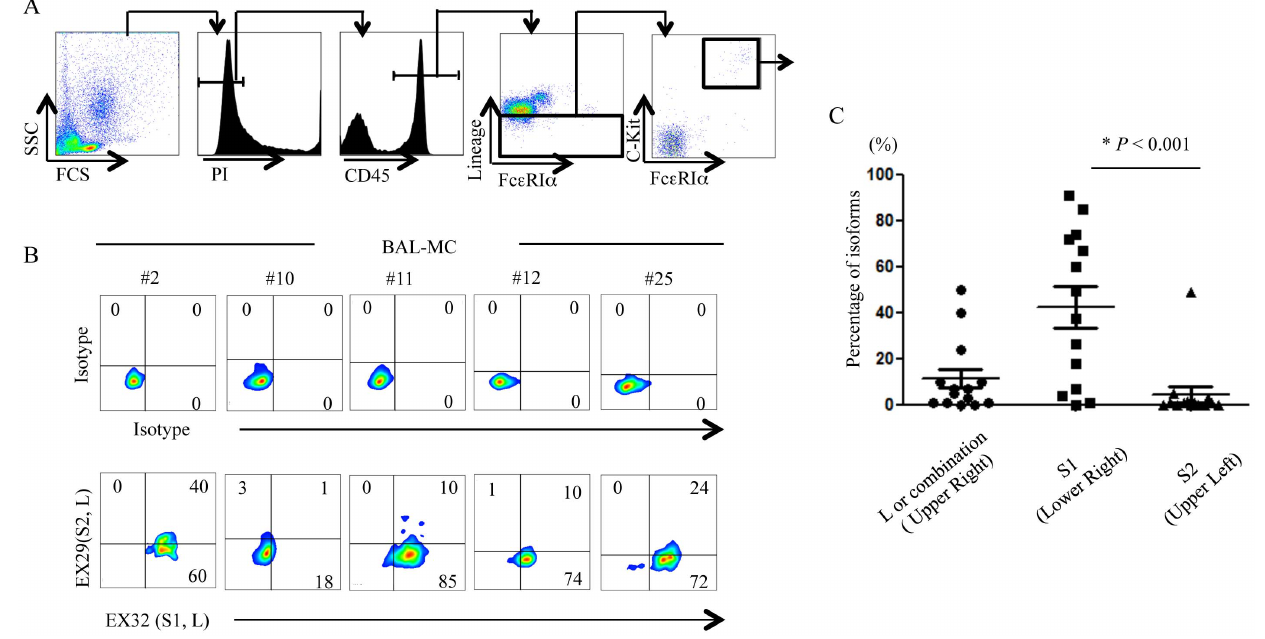
Figure 4. Expression of Allergin-1 isoforms on human BAL-MC. Cells obtained from the BALF of patients with pulmonary diseases were stained with PI, anti-CD45, lineage mAb cocktail, anti-Fc e RI a , and anti-c-Kit mAbs together with isotype control, and EX32 and/or EX29 mAb, and the BAL-MC were analyzed by using flow cytometry (A). Representative flow cytometry profiles of five patients are shown (B). ‘‘Combinations’’ indicates MC in the upper right quadrant that express either L + S1, L + S2, L + S1 + S2, or S1 + S2 (C).